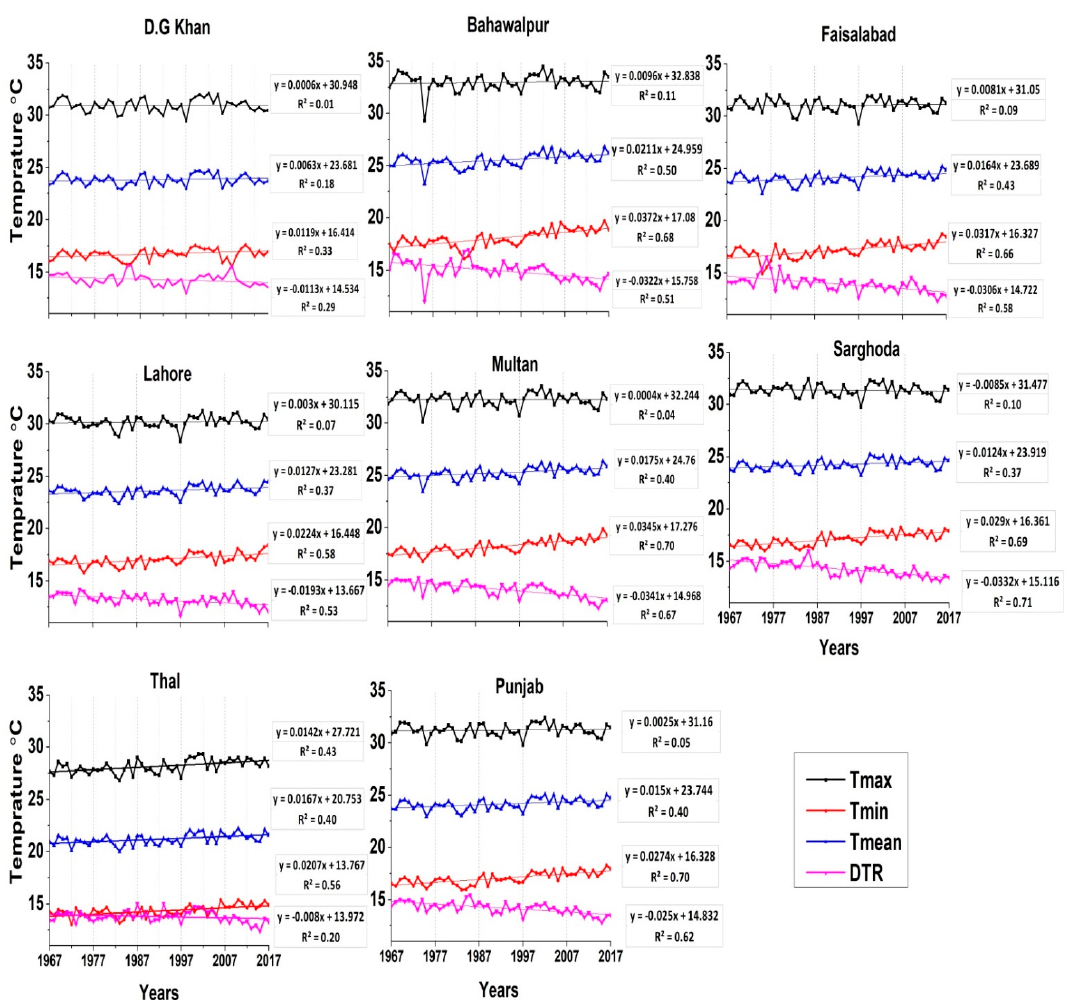
Figure 2. Time series of annual maximum temperature (T max ), minimum temperature (T min ), mean temperature (T mean ) and diurnal temperature range (DTR) in degree celcius (°C) for the Punjab irrigation zones and their linear trends.